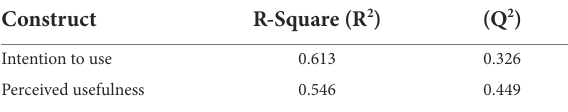
TABLE 4 Predictive accuracy and relevance of the